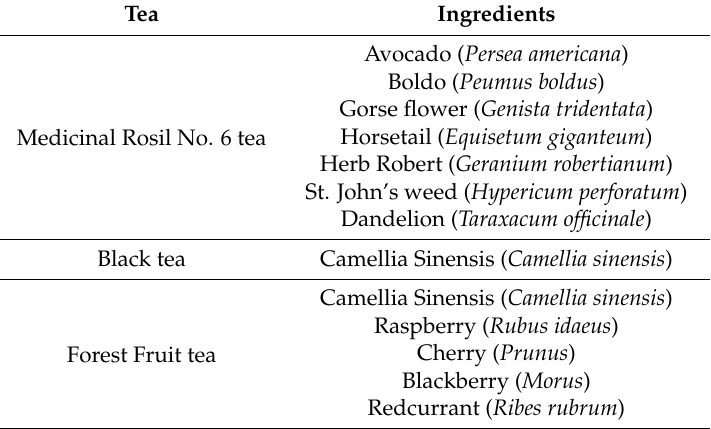
Table 1. Main ingredients of